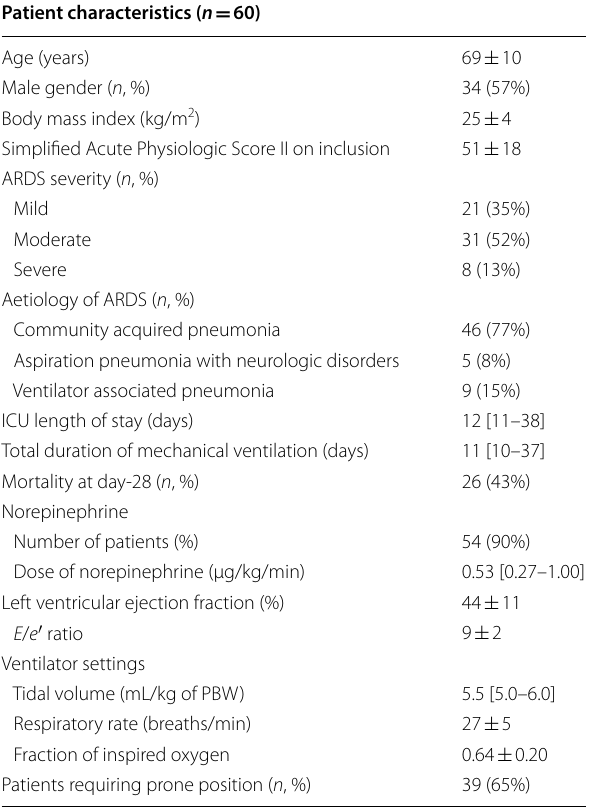
Table 1 Patient